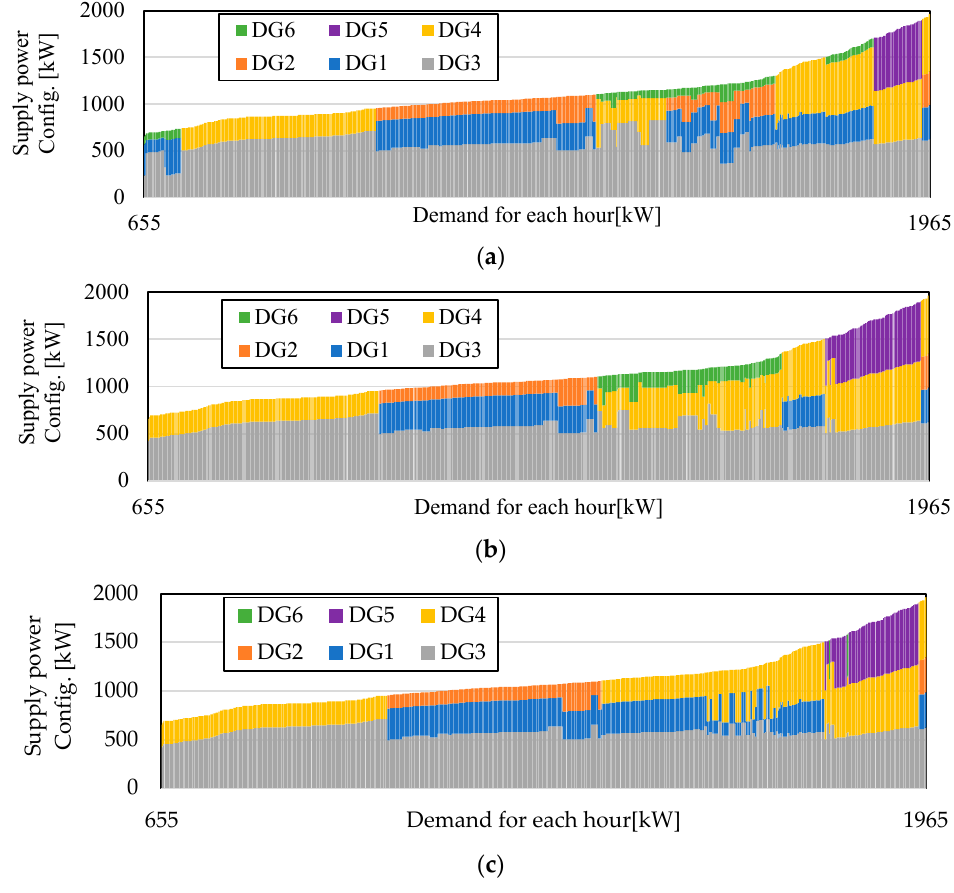
Figure 8. The load sharing pattern of the five units of medium-speed with one unit of high-speed DGs operated by the optimized load sharing method. ( a ) The five units of medium-speed + 200 kW the high-speed DG. ( b ) The five units of medium-speed + 500 kW the high-speed DG. ( c ) The five units of medium-speed + 800 kW the high-speed DG.